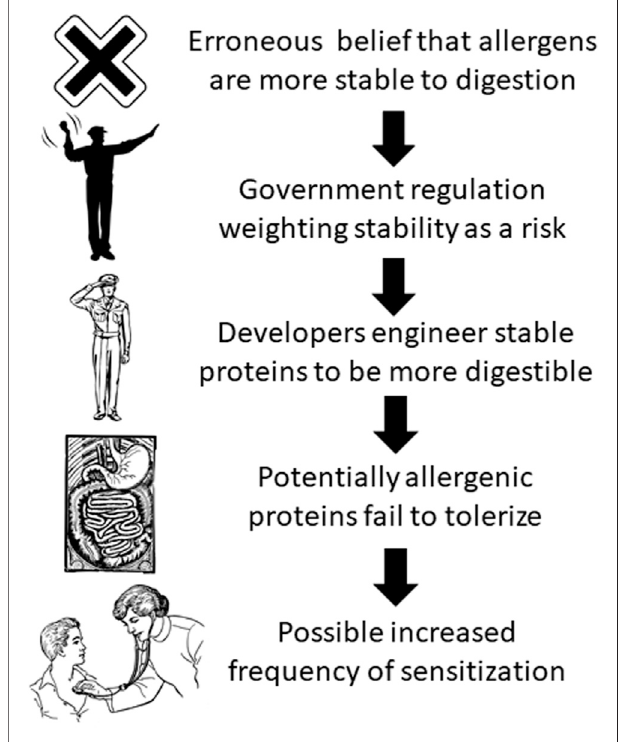
FIGURE 1 | Possible result of erroneous belief that allergens are more stable to digestion than non-allergens (artwork from https://